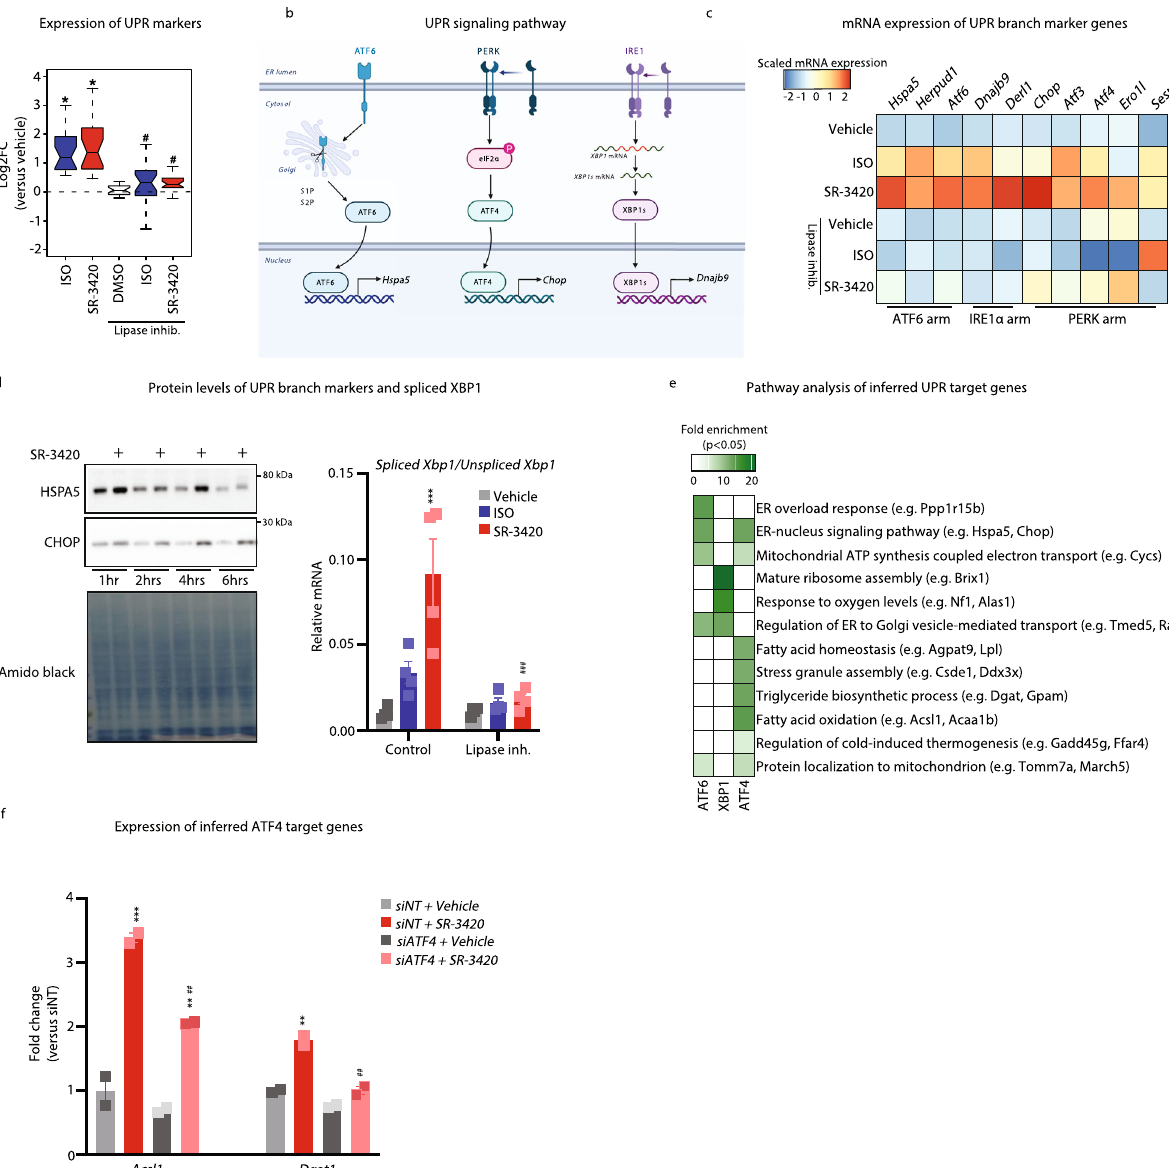
Fig. 5 Activation of unfolded protein response by lipolysis. Mouse in vitro differentiated brown adipocytes were pre-treated with 10 µ M Atglistatin (ATGL inhibitor) and 20 µ M CAY10499 (HSL inhibitor) for 1 h and subsequently with 100 nM isoproterenol (ISO) (blue bar) or 20 µ M SR-3420 (red bar) for 3 h before harvest. a Boxplot illustrating mRNA expression derived from RNA-seq, expressed as fold change activation by ISO and SR-3420 ±lipase inhibitors of 24 established UPR marker genes relative to the vehicle. Boxplots (notch, mean; box, fi rst and third quartiles; whiskers, 1.5 times the interquartile range. n = 3 biologically independent experiments examined, each carried out in a technical duplicate b Model depicting the different UPR signaling pathways. Created with BioRender.com. c Heatmap indicating the mRNA expression of UPR marker genes derived from RNA-seq of the three UPR signaling branches in response to the different treatments. n = 3 biologically independent experiments examined, each carried out in technical duplicates. d Western blot showing levels of CHOP and HSPA5 in in vitro differentiated mouse-brown adipocytes stimulated with 20 µ M SR-3420 for 1, 2, 4, and 6 h before harvest. Amido black is used as loading control. mRNA expression of spliced Xbp1 / unspliced Xbp1 derived from RT-qPCR n = 4 biologically independent experiments examined for RT-qPCR data and Western blots are representative of n = 2 biologically independent experiments examined e Heatmap indicating the enrichment of gene pathways (FDR < 0.05) among inferred ATF6, XBP1 or ATF4 target genes in mouse-brown adipocytes. f mRNA expression of inferred ATF4 targets genes quanti fi ed by qPCR of in vitro differentiated mouse-brown adipocytes with or without knockdown of Atf4 ( siAtf4 ) and subsequently stimulated with 20 µ M SR-3420 for 3 h. n = 2 biologically independent experiments examined, each carried out in a technical duplicate For all panels, error bars represent ±SEM of 2 – 4 independent biological experiments, each carried out in technical duplicates. Statistical signi fi cance was determined by Wilcoxon Signed-rank test for a and one-way ANOVA with Tukey ’ s multiple comparisons test for d , f ( p ≤ 0.05 = *, p ≤ 0.01 = **, p ≤ 0.001 = ***). * versus Vehicle/Control, # versus ISO or SR-3420 (without Lipase inh. or